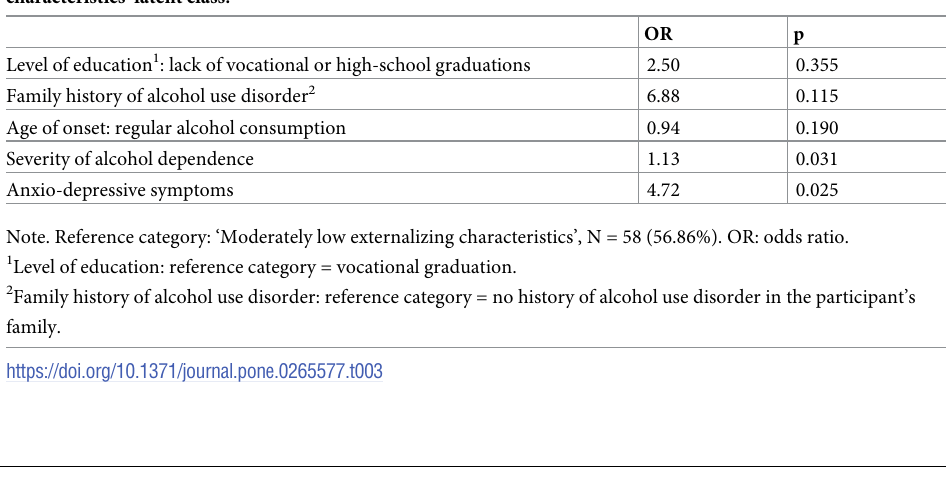
Table 3. Binary logistic regression: Predictive effects on the membership of the ‘Moderately high externalizing characteristics’ latent